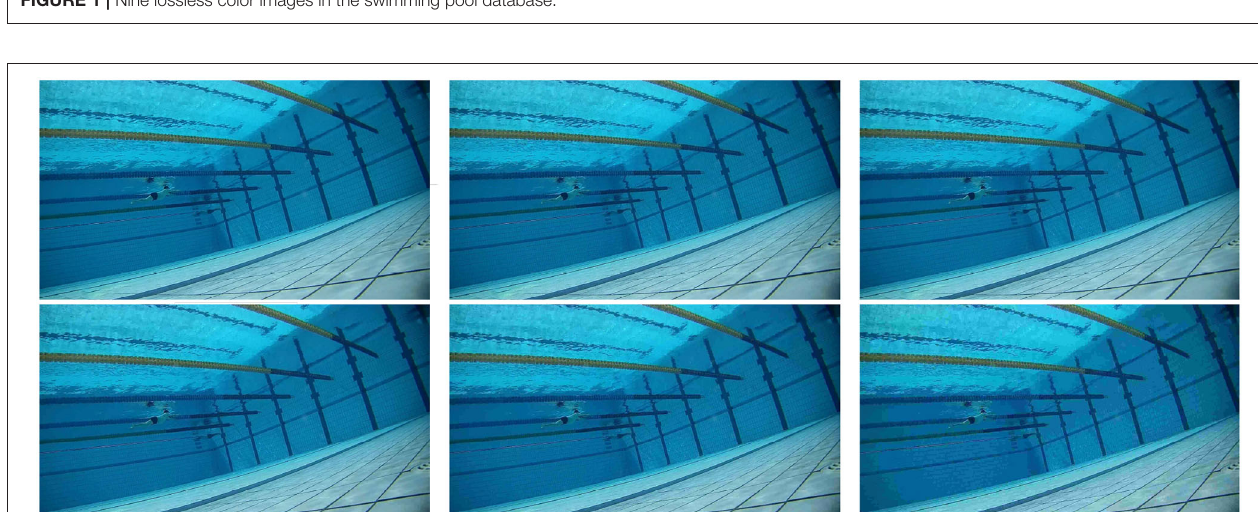
FIGURE 1 | Nine lossless color images in the swimming pool database.